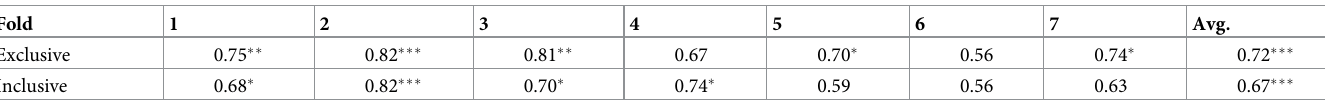
Table 4. Accuracy of the exclusive and inclusive models when predicting unseen